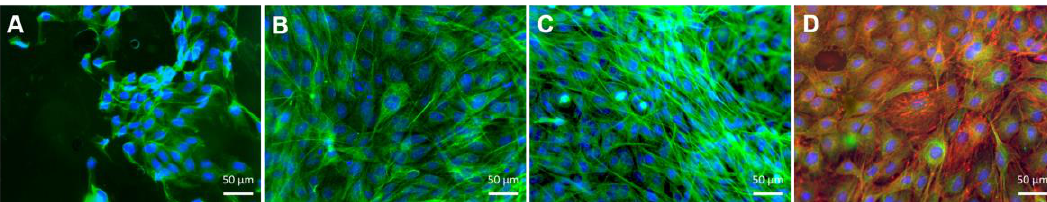
Figure 8. Osteopontin immunofluorescence images of MC3T3-E1 cells stained in green and with DAPI (in blue), after 14 days in osteogenic medium and cultured on the ( A ) [CHT/HA] 200 and ( B ) [CHT/HA-DN] 200 membranes and ( C ) TCPS (positive control); ( D ) Merged image of MC3T3-E1 cells cultured on the [CHT/HA-DN] 200 membrane is shown in the overlay with osteopontin (green), phalloidin (red) and DAPI (blue) markers.